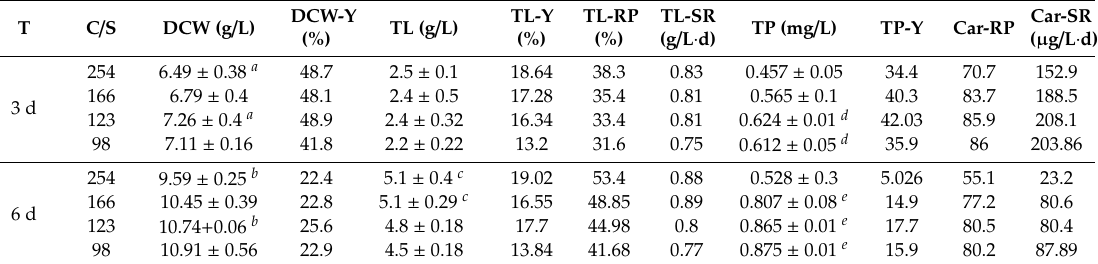
g glucose ). TL-SR: total lipid synthesis rate. Car-SR: carotenoid synthesis rate. d: days. The data are the mean of three repeat tests, and the standard deviation represents ± SD. The significance of the C/S ratio on DCW, TL, and TP after three and six days were detected by using a one-way ANOVA test in SPSS. a represents each of the DCW-3d significant differences with DCW-98-3d ( p < 0.05). b represents each of the DCW-6d significant differences with DCW-98-6d ( p < 0.01). c represents each of the TL-6d significant differences with TL-98-6d ( p < 0.05). d represents each of the TP-3d significant differences with TL-254-3d ( p < 0.01). e represents each of the TP-6d significant differences with TL-254-6d ( p < 0.05).